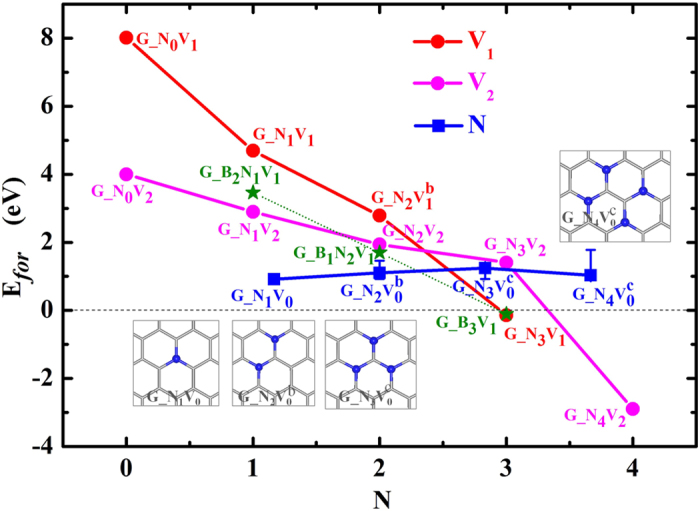
The formation energies (Efor) of C-vacancies and N-dopings as a dependence of the number of nitrogen atoms in the G_NxVy substrates.Insets show the G_NxV0 structures used in Efor calculations without C-vacancy, where the gray sticks and blue balls represent C and N atoms, respectively.